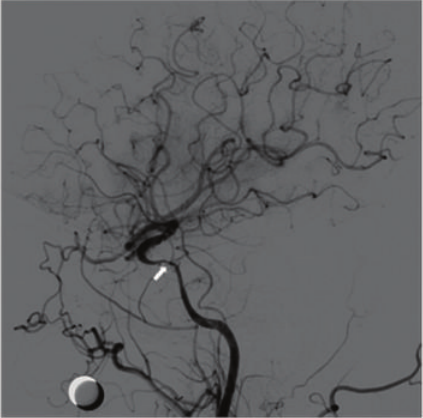
Figure2:Digitalsubtractioncerebralangiography:moderatesteno- sis at right cavernous internal carotid artery with